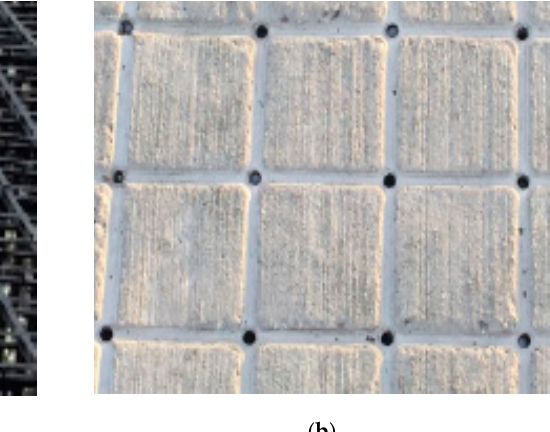
Figure 1. ( a ) The surface layer of JW Eco-technology aqueduct frame before concrete was poured; ( b ) an example of the finished JW Eco-technology surface.